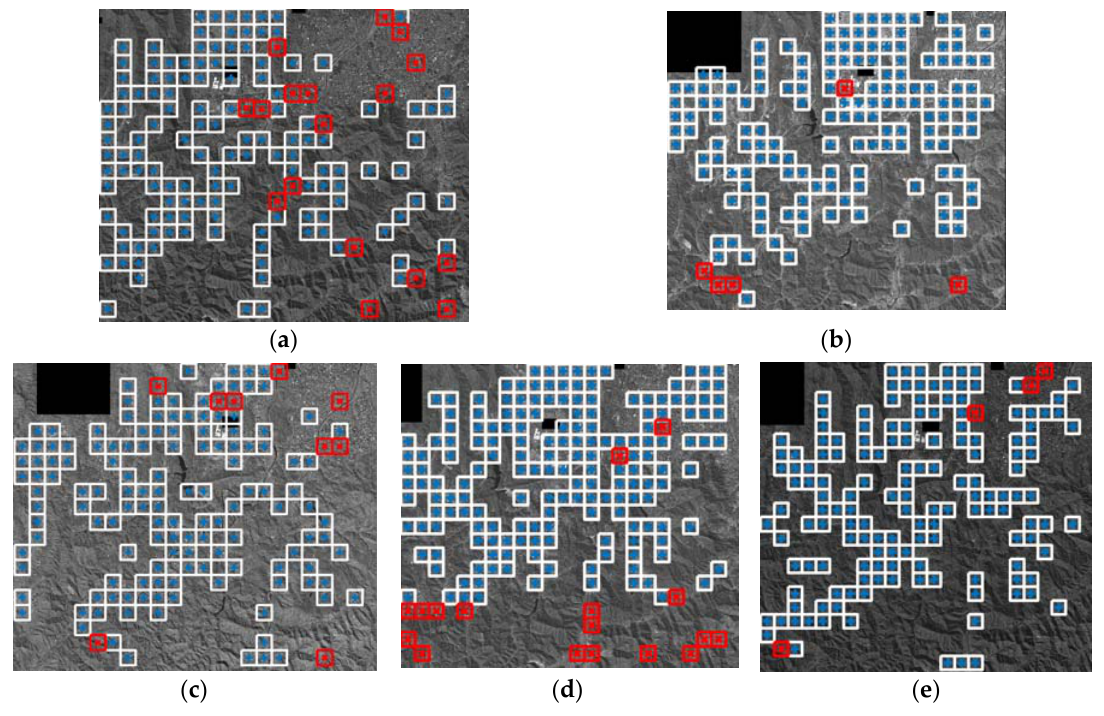
Figure 5. RECC matching results: ( a ) K3-1; ( b ) K3-2; ( c ) K3-3; ( d ) K3-4; and ( e ) K3-5. Correct matches and outliers are marked as blue + and red x, respectively.